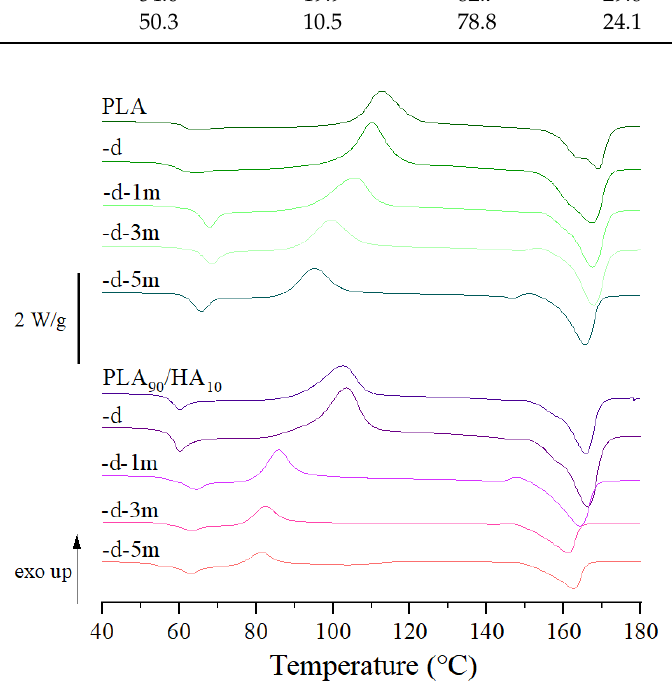
Figure 11. Representative DSC thermograms of the scaffolds after processing, decontamination, and conditioning in cell culture medium at 37 °C up to 5 months.